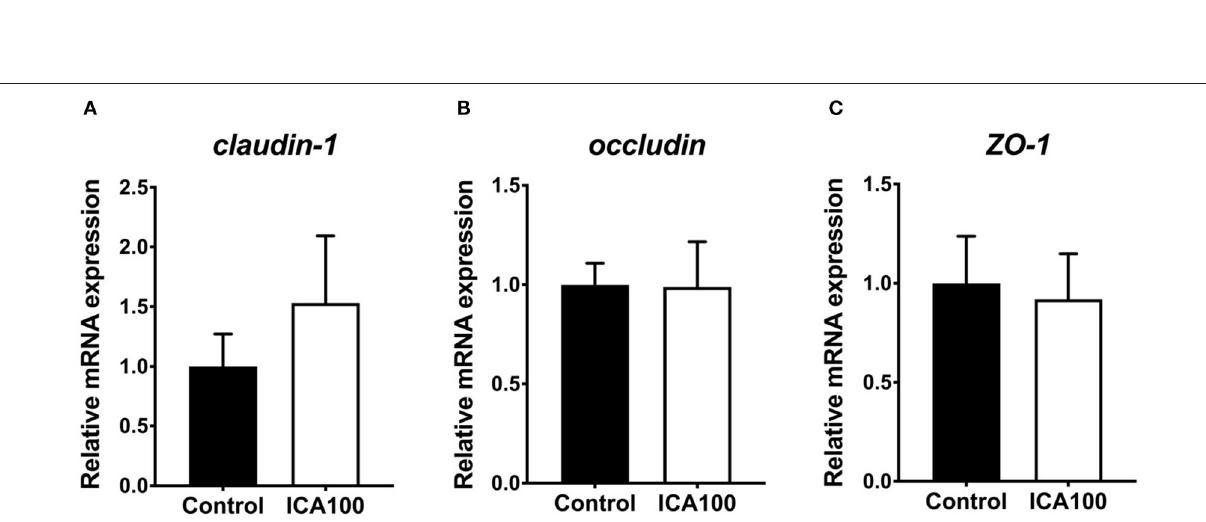
FIGURE 3 | Effects of dietary ICA supplementation on the mRNA expression of claudin 1 (A) , occludin (B) , and ZO-1 (C) in the jejunum of weaned piglets. Data are expressed as mean ± SEM. ICA100, the basal diet supplemented with 100 mg/kg indole-3-carboxaldehyde. ZO-1, zonula occludens 1.